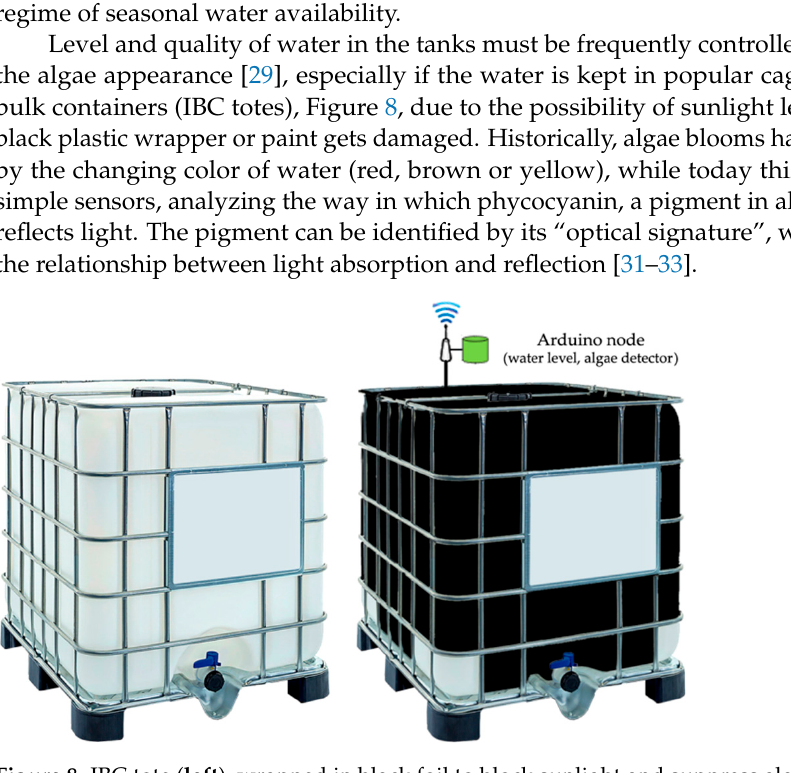
will provide dry running protection on the pump, prevent unnecessary cycles if the upper tank is full, or if the battery is not charged enough to power the